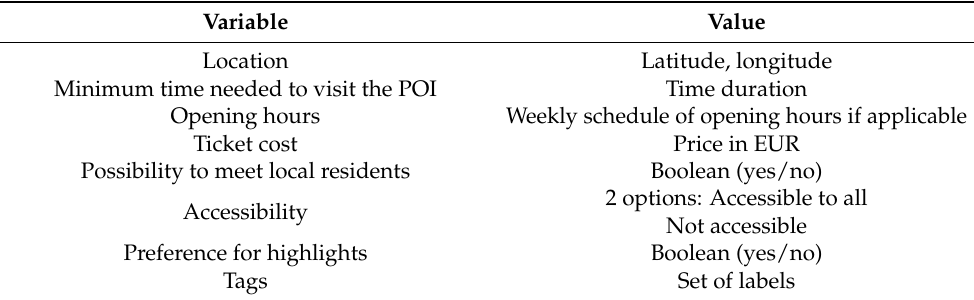
Table 3. POI characteristics to support